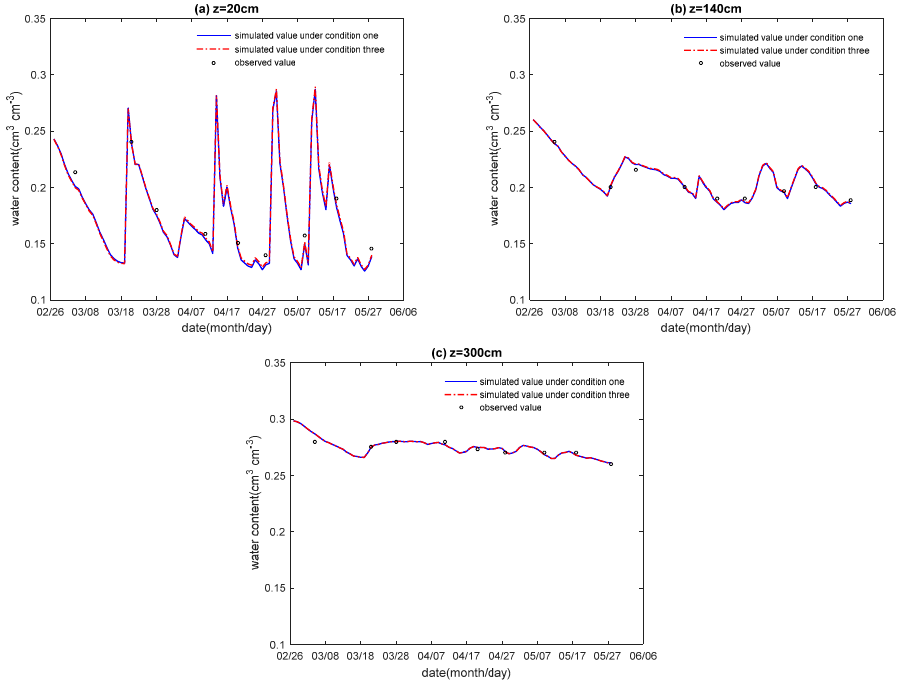
Figure 8. Comparison between simulated and observed values for soil water content with time at different soil depths under conditions one and three.